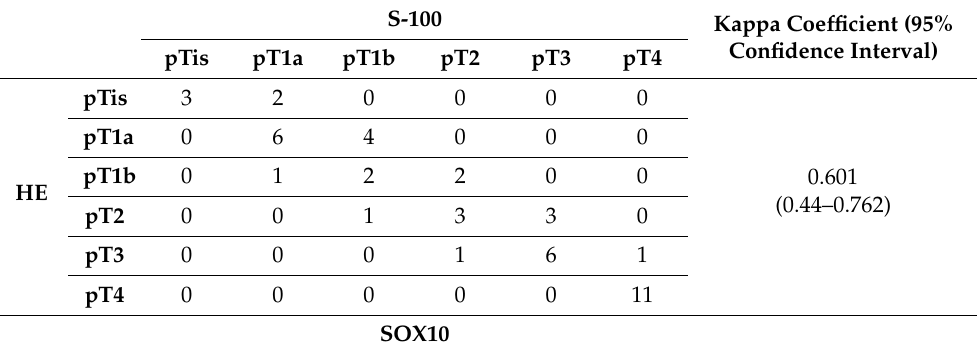
Table 5. Agreement rate between the T category obtained on HE and IHC